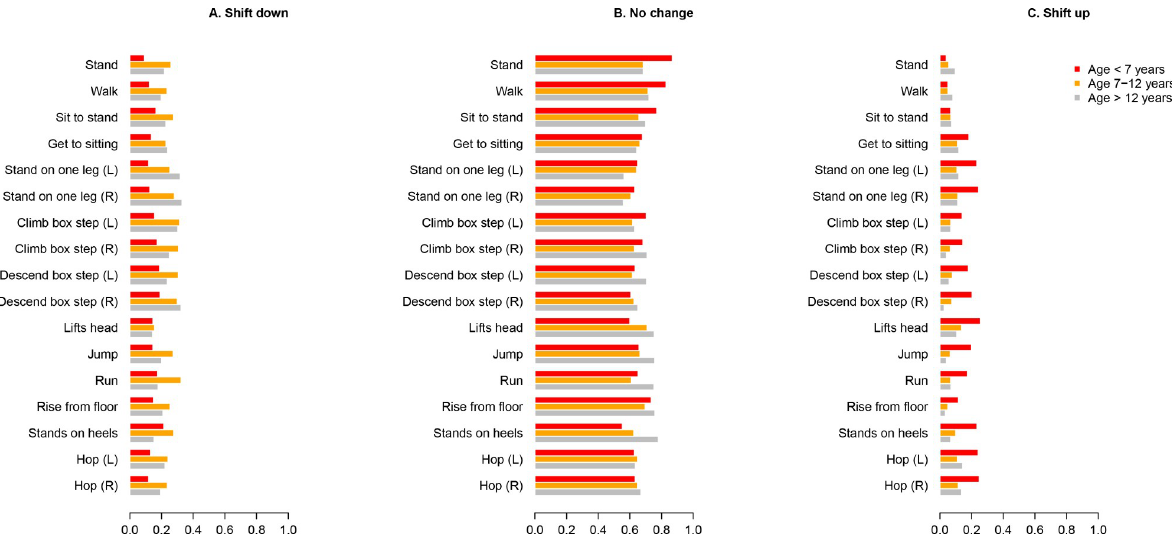
Fig 5. Shifts in NSAA item scores over 1 year: stratification by age. Annualised probabilities of (A) deterioration (shift down); (B) stable function (no change); or (C) improvement (shift up) in the population with DMD stratified by age groups. DMD, Duchenne muscular dystrophy; L, left; NSAA, North Star Ambulatory Assessment; R,